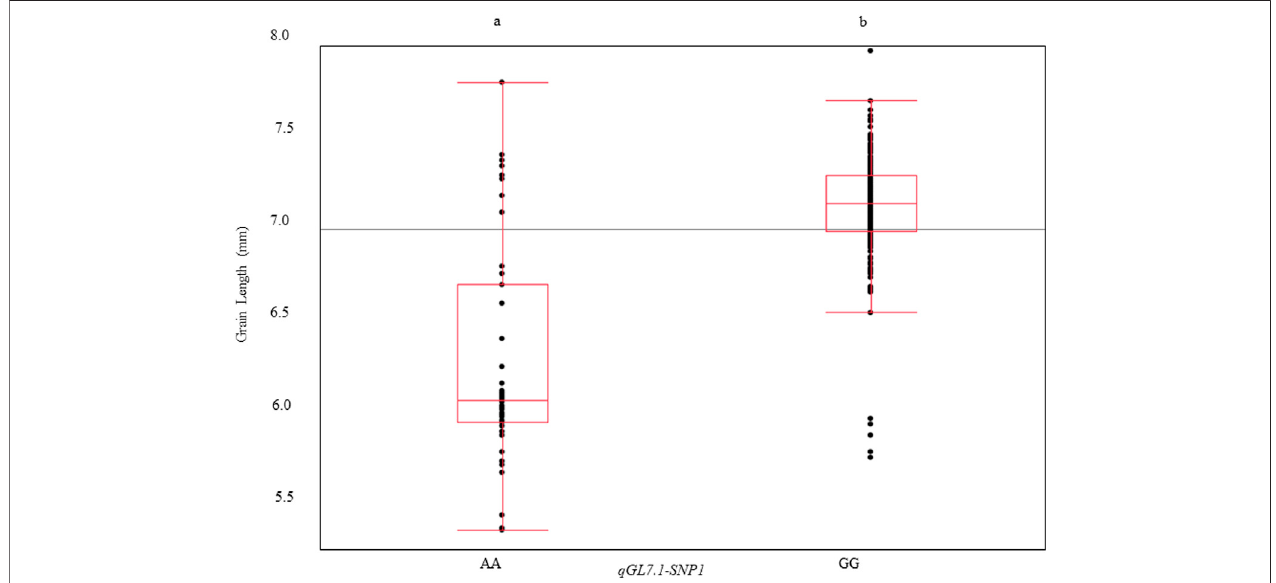
FIGURE 3 | Grain length variation explained by qGL7.1 -SNP1 (LSU-1480) across a U.S. rice germplasm panel. qGL7.1-SNP1 was identi fi ed in the HDRA dataset that was obtained from SNP-Seek online portal within the qGL7.1 QTL region. QTL qGL7.1 was detected on Chromosome seven in Trenasse/Jupiter RIL population. qGL7.1-SNP1 differentiated long-grain haplotypes from medium-grain haplotypes within U.S. lines of HDRA dataset. Allele A is associated with the medium-grain genotypes and allele G is associated with long-grain genotypes. Different alphabet letters on each class represent the statistically signi fi cant difference p < 0.001 within each